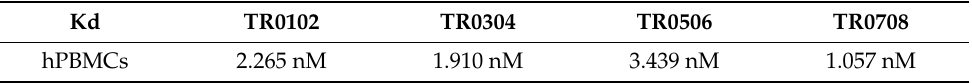
Table 2. Kd values obtained from the binding curves of the tribodies to activated